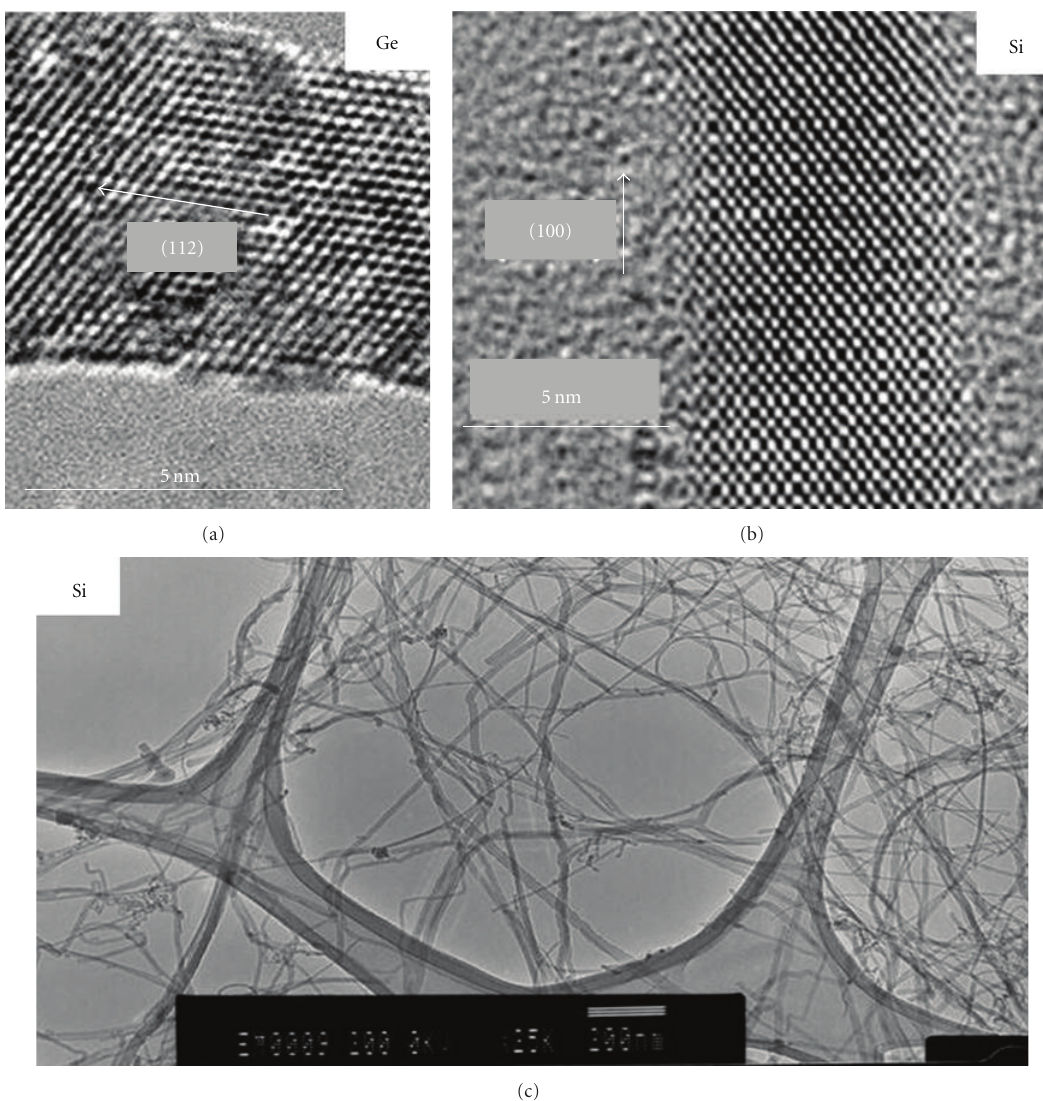
Figure 8: HRTEM images of (a) 6nm diameter Ge nanowire [80], (b) 7nm Si nanowire [47], and (c) LRTEM images of Si